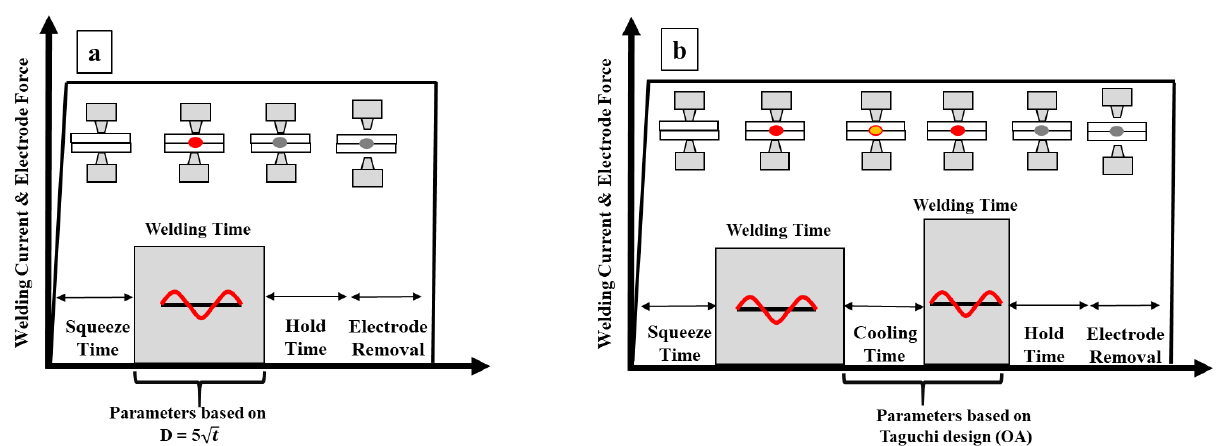
Figure 1. Resistance spot welding (RSW) schemes ( a ) SPW; ( b ) double-pulse welding (DPW). (Reprinted from [26] with permission from Elsevier). Table 2. Parameters and their levels for the single pulse welding (SPW) scheme. (Reprinted from [26] with permission from Elsevier)